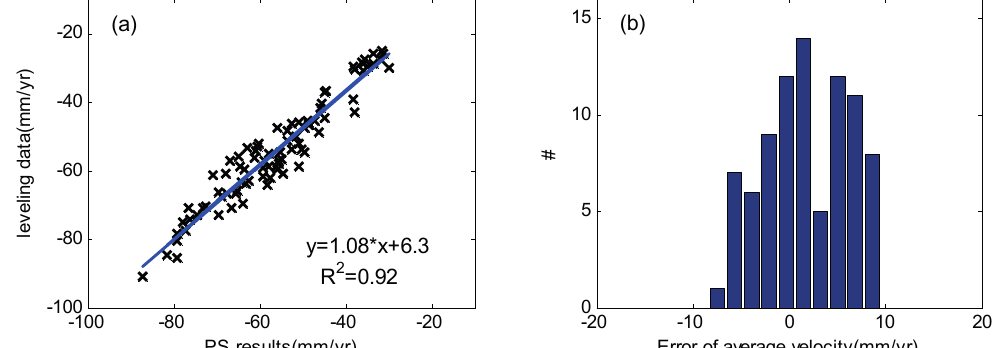
Figure 6. Regression analysis and error histogram of average velocity between PS results and leveling measurements. ( a ) Regression of average velocity by using average method; ( b ) Error histogram of average velocity by using average method; ( c ) Regression of average velocity by using nearest neighbor method; ( d ) Error histogram of average velocity by using nearest neighbor